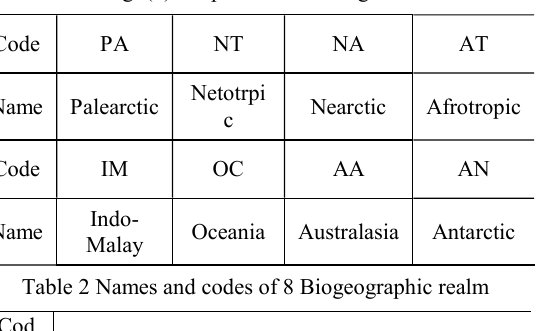
Fig1(a).8 Biogeographic realm and 14 Biomes Fig1(b).Shape file of